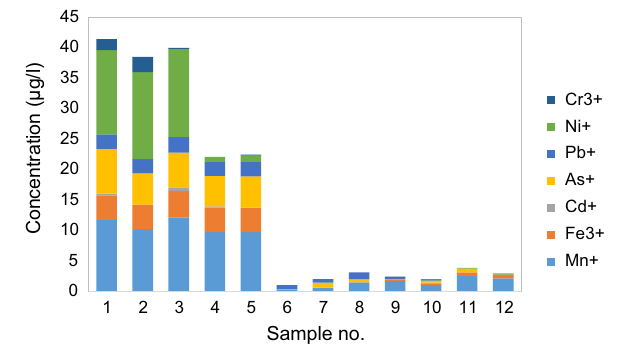
Fig. 9 Heavy metal concentrations of the tested water sources